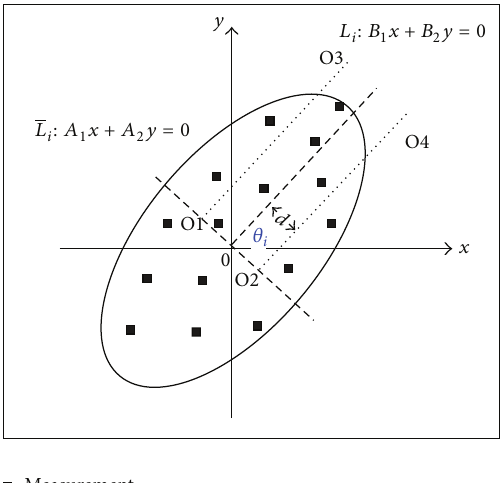
Figure 1: Angle interval